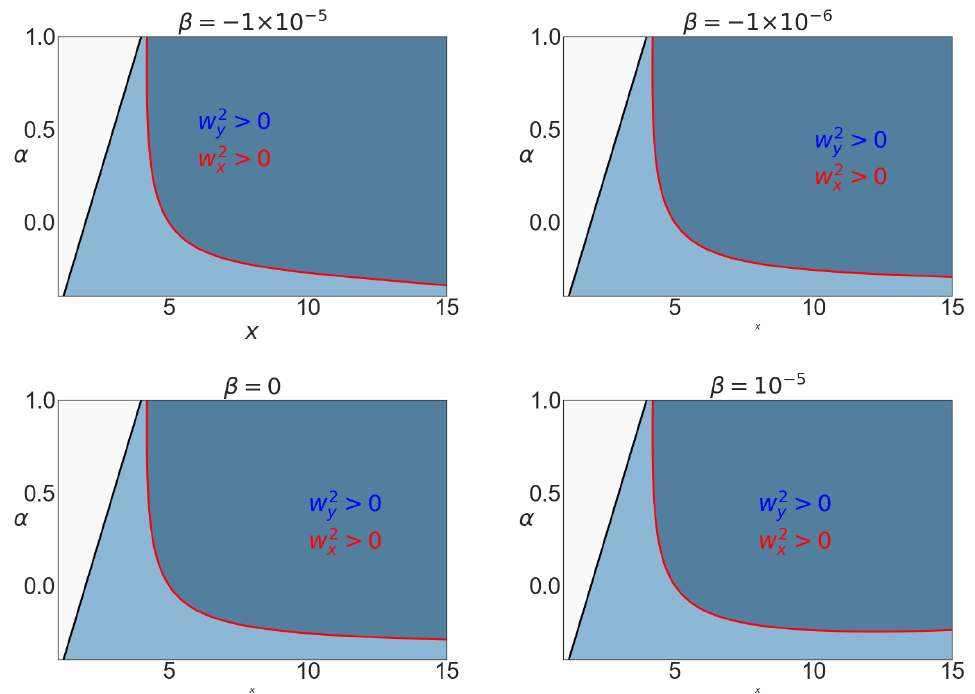
Figure 4. Stability of timelike circular orbits in the ( x , α )-plane. Timelike circular orbits exist in the light blue area. This region is bounded by the thick dark line ( 2 S − x = 0 ) . The red curve represents w 2 x = 0. The area depicted by the blue-gray region shows the domain of stability. In the chosen range, w 2 y > 0 in the entire light blue region. Timelike orbits are stable above the red curve with respect to vertical perturbations and radial perturbations. On the contrary, below the red curve and in the light blue region, the timelike geodesics are stable with respect to vertical perturbations but unstable with respect to radial